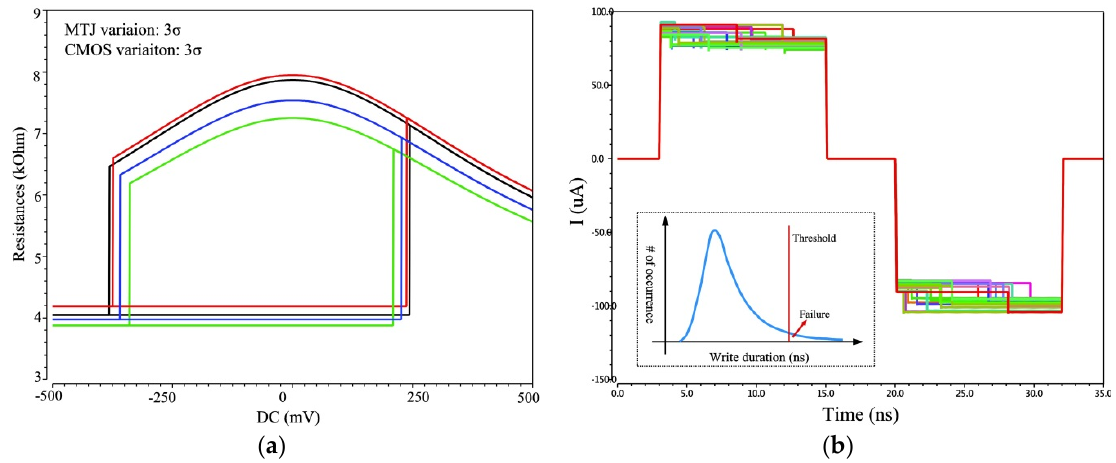
Figure 6. ( a ) DC simulations (4 times) of the perpendicular magnetic anisotropy (PMA) STT ‐ MTJ/CMOS hybrid circuit to validate the correctness of the spice model, with 3σ variations of both the MTJ and the CMOS access transistor. ( b ) Monte Carlo statistical simulation of the write operations: parallel (P) to anti ‐ parallel (AP) and back to parallel (P). Write error may occur if the write duration is less than the required value.